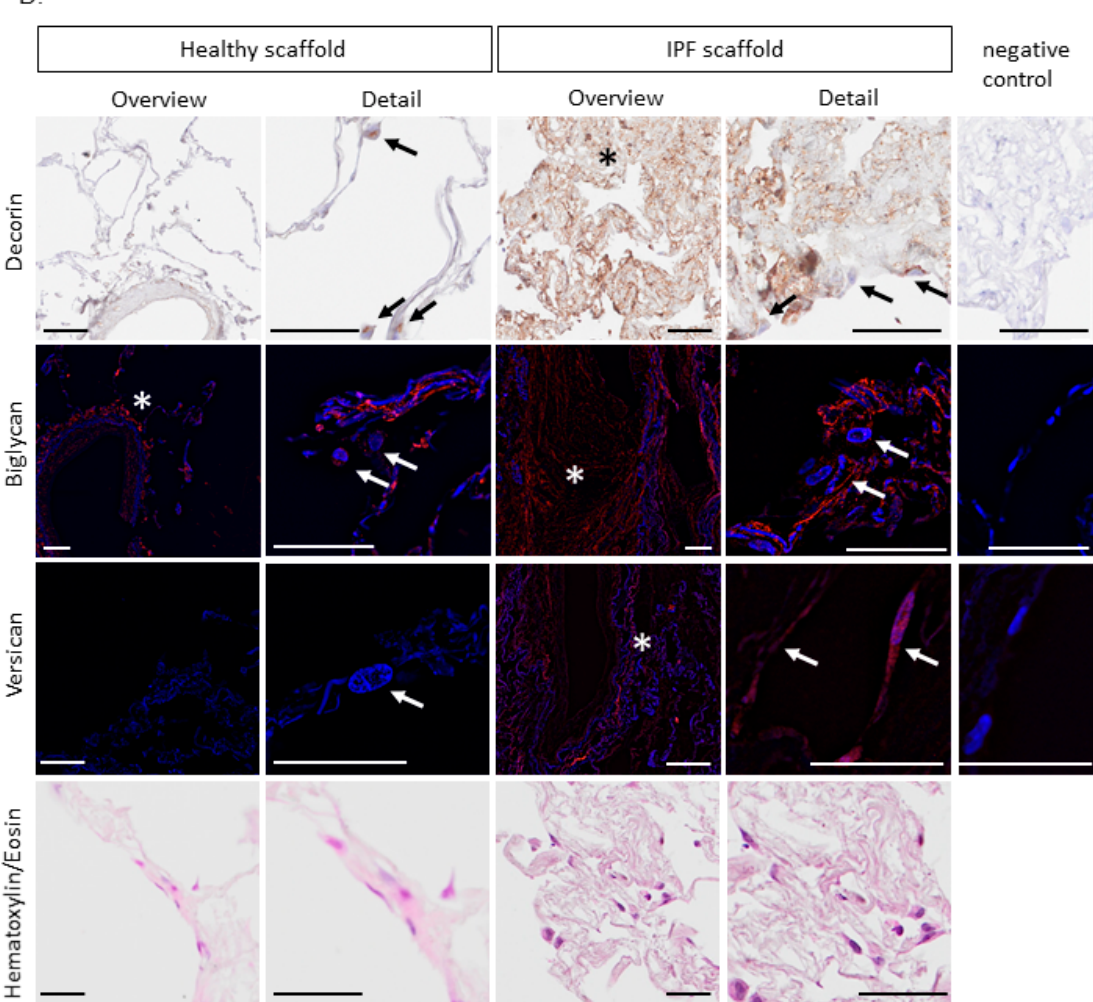
Figure 6. ( A ) Graphs of heavy and light intensity/mm 3 of tenascin and periostin of repopulated scaffolds (biological replicates n = 4, technical replicates n = 2) with calculated grand mean. Student’s t -test for significance between patient groups means for each time point (* p < 0.05). ( B ) Periostin in repopulated scaffolds (day 1). Antibody labeling indicating periostin (brown) in certain areas in alveolar septa in the healthy scaffolds, and to a stronger degree in less remodeled tissue areas in the IPF scaffolds. Largely absent periostin staining in heavily remodeled IPF tissue areas (*). Arrows highlight differences in intracellular staining. Scale bar overview 500 µm, details 10 µm. ( C ) Graphs of original (light) and newly synthesized (heavy) proteoglycans decorin, biglycan, and versican of repopulated scaffolds (biological replicates n = 4, technical replicates n = 2) are presented with calculated grand mean of light and heavy intensity at day 1. Student’s t -test for significance between patient groups (* p < 0.05, ** p < 0.01). ( D ) Antibody staining illustrating proteoglycan increase in IPF vs. healthy scaffolds (day 1) of newly synthesized proteoglycans including original scaffold composition. Decorin (brown): IPF scaffold showing intrinsically more decorin, with cellular signal in fibroblasts on both scaffold types. Biglycan (red): rare intrinsic biglycan in healthy scaffolds apart from vessels, but strong accumulation in IPF scaffolds. Cellular signal of biglycan in fibroblasts on both scaffold types were seen. Versican (red): absent intrinsic versican in healthy scaffolds, but distinct accumulation in IPF scaffolds. Prominent cellular signal in fibroblasts on IPF scaffolds, but not on healthy scaffolds. * extracellular deposition in repopulated scaffolds. Arrows highlight differences in intracellular staining. Corresponding hematoxylin/eosin staining of the repopulated scaffolds shown in bottom row. Scale bar 50 µm.